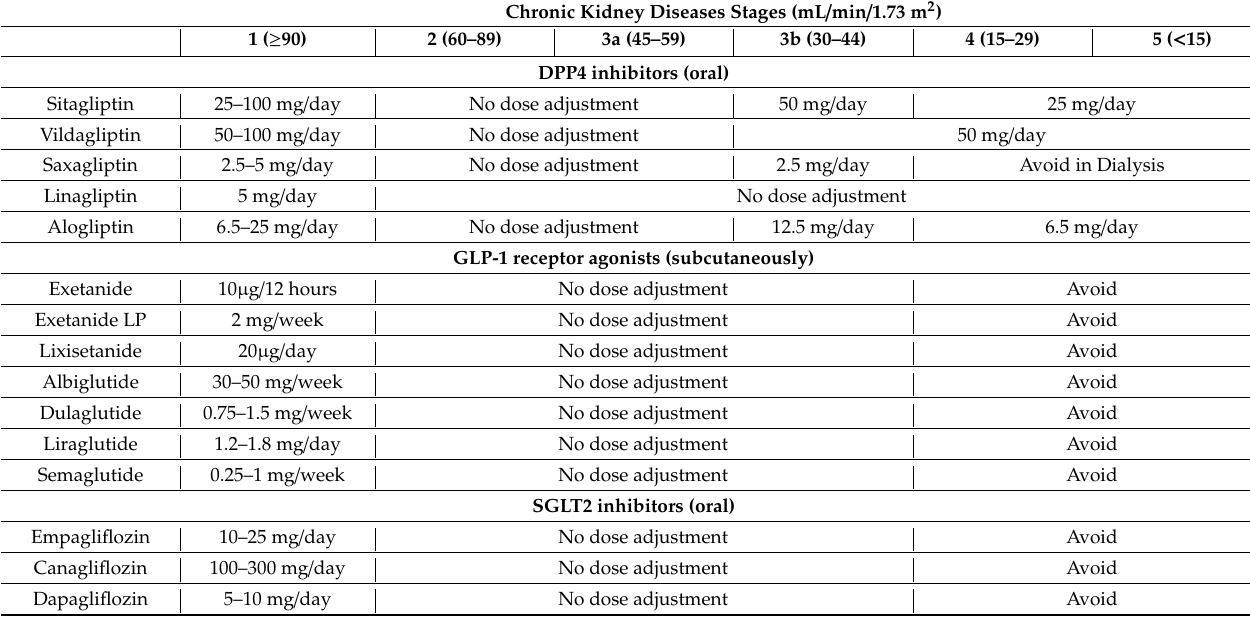
Table 2. New antidiabetic drugs, dipeptidyl peptidase 4 (DDP4) inhibitors, GLP-1 receptors agonists and SGLT2 inhibitors dose and drug indications according chronic kidney disease